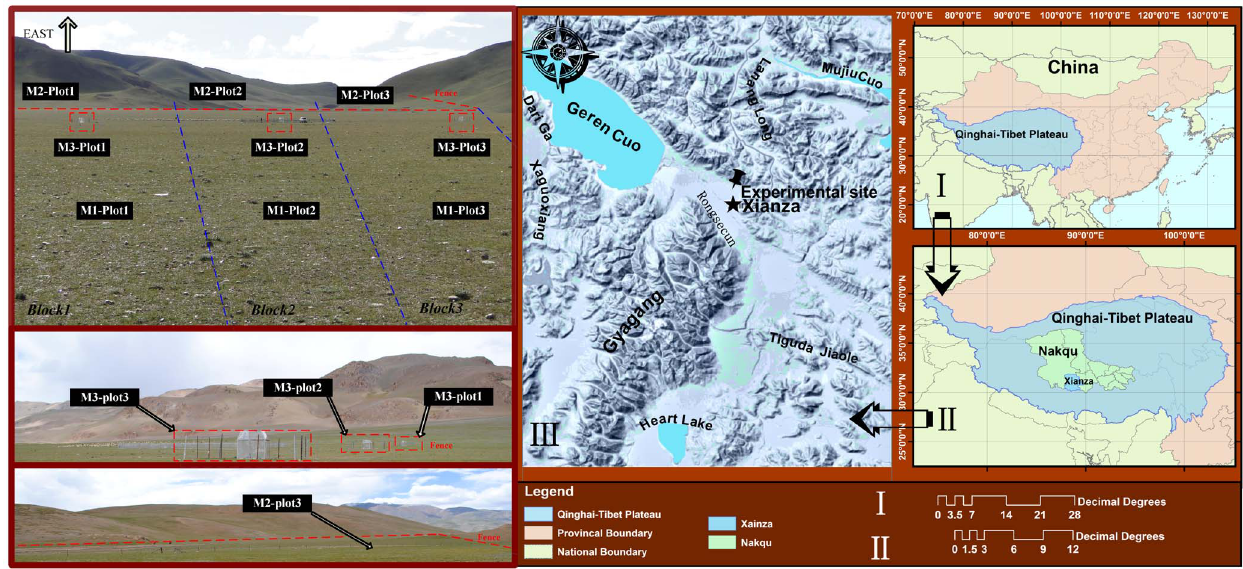
Figure 1. The experiment sites in alpine steppe, northern Tibetan Plateau.